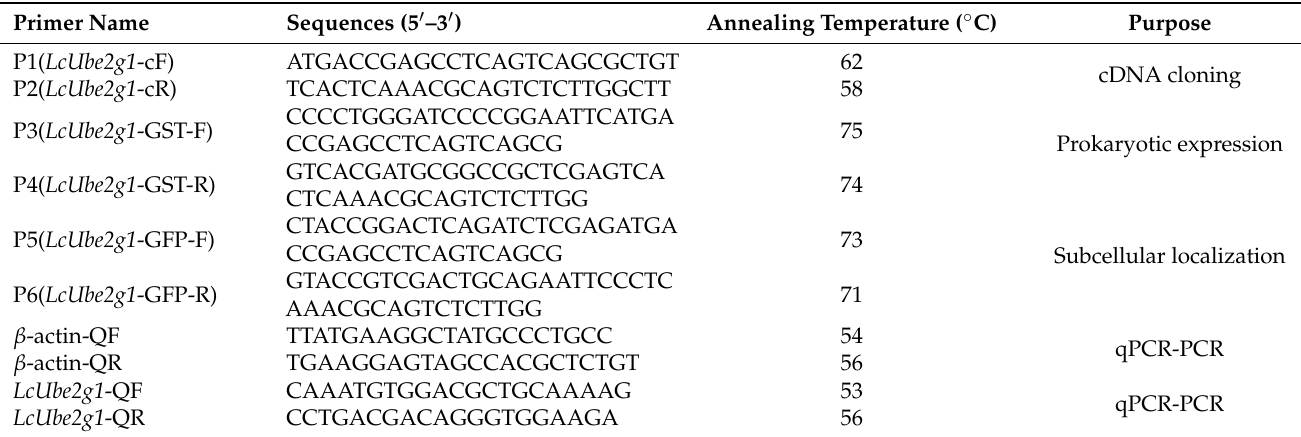
Table 2. Primers used in this